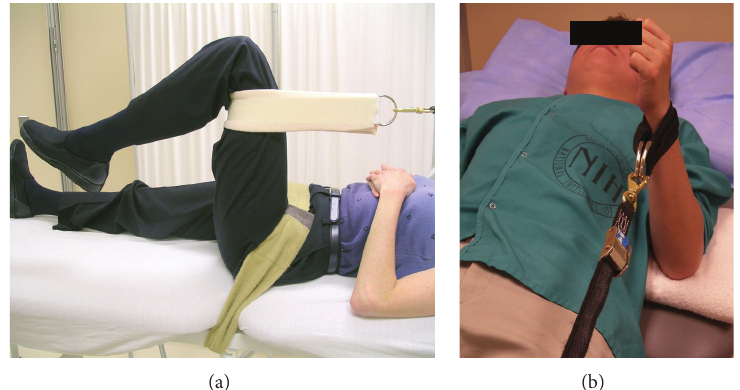
Figure 1: Isometric maximal voluntary contraction testing via the quantitative muscle assessment device. (Participant positioning shown for the: (a) hip extensors and (b) elbow